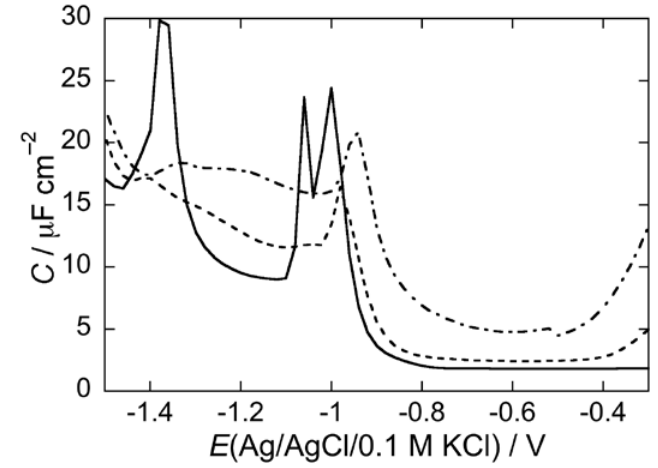
Figure 7. AC voltammogram at a SAM of a DOPC/PSM (2:1) mol% lipid mixture in a pH 5.4 unbuffered solution of 0.1 M KCl in the absence of CSF114 (solid curve), and in the presence of 2 μg/mL CSF114 after five potential scans from −0.2 to −1.5 V (dashed curve) and after a single EIS scan (dash-dotted curve). Frequency = 75